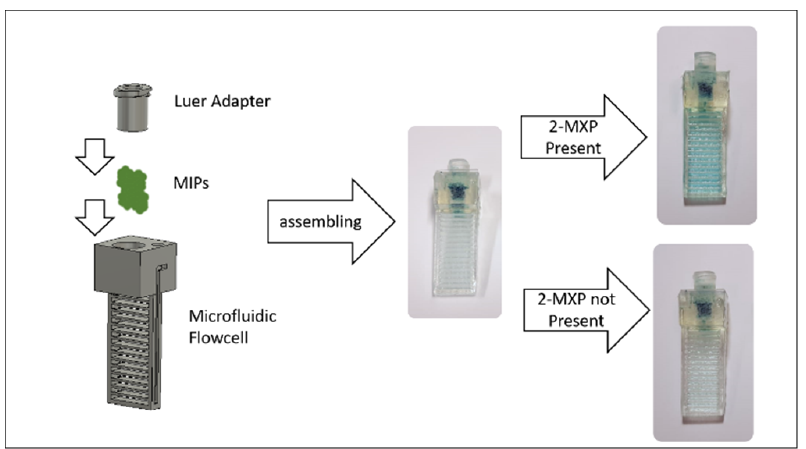
Figure 9. A microfluidic ‘cuvette’ with the same width and depth as a cuvette; this device can be used in any standard UV/Vis spectrophotometer to conduct online measurements. It is filled with molecular imprinted polymers loaded with a malachite green, which is released on contact with the drug 2-MXP.